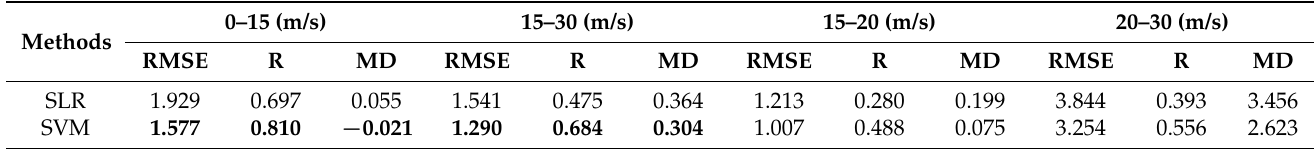
Table 8. Retrieval performance of SLR and SVM.